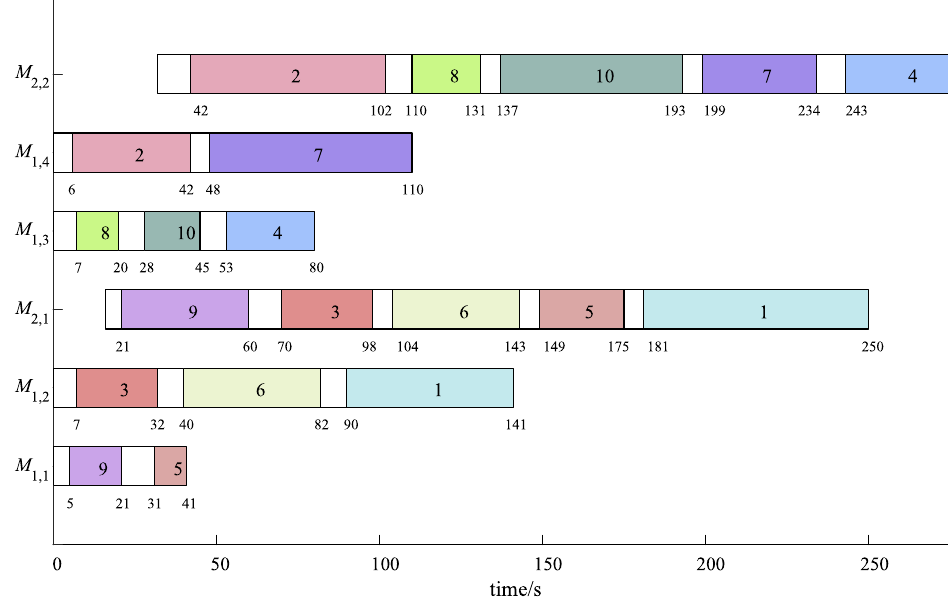
Figure 2. The schedule of the possible